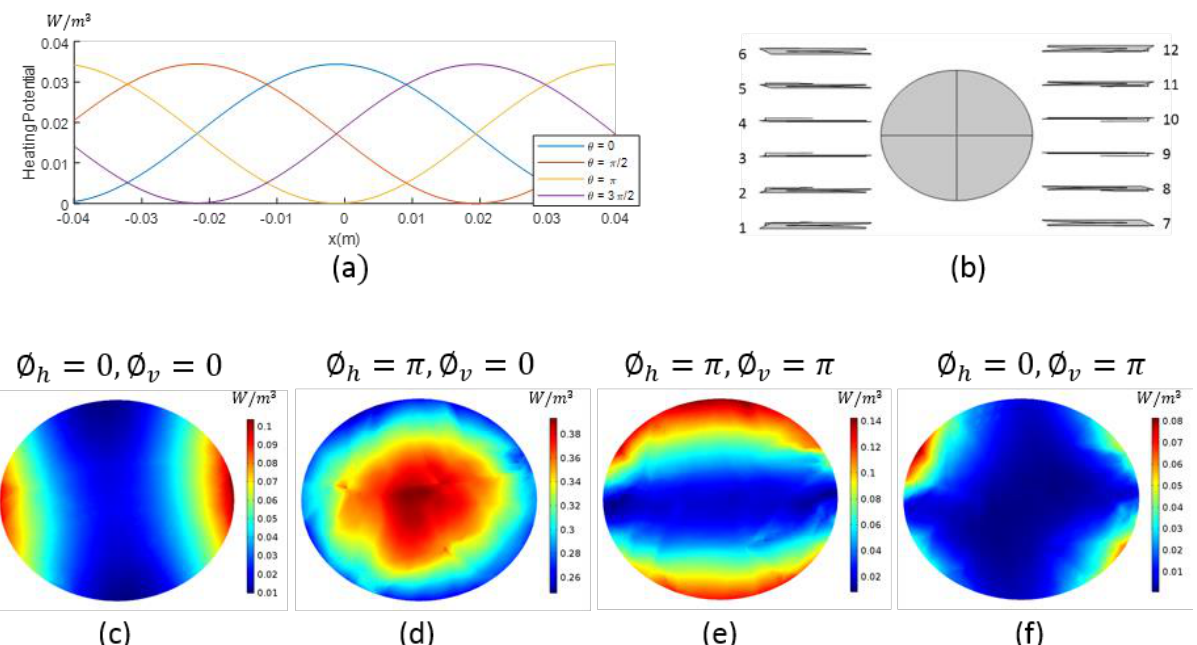
Figure 1. ( a ) Superposition of two opposite propagating plane electromagnetic waves, where θ is the phase difference of the waves; ( b ) Top view of the simulation configuration with antenna numbering and homogeneous fat phantom; ( c – f ) Heating potential of homogeneous fat phantom with the given sub-antenna arrays phase adjustments.